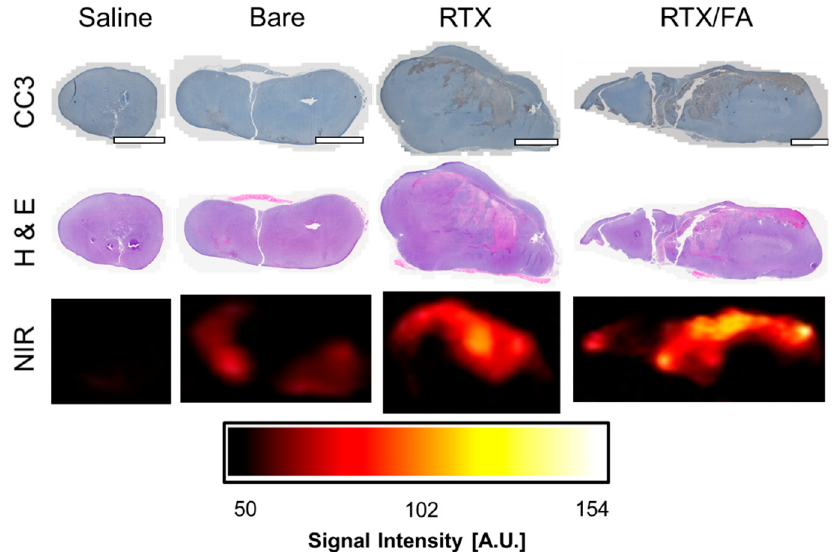
Figure 7. Tumor toxicity associated with NP treatments. Cleave-caspase 3 and H & E stained representative tumors show potential in vivo toxicity of the RTX and RTX / FA formulations. Scale bar indicates 1 mm. Brown color indicates regions of apoptosis, which are more prevalent in the RTX and RTX / FA-treated organs. Unstained slides were scanned at lower resolution using a LI-COR Odyssey fluorescent scanner at the 700 nm setting, which appear to show higher signal in regions that showed higher cell death in similar slices.